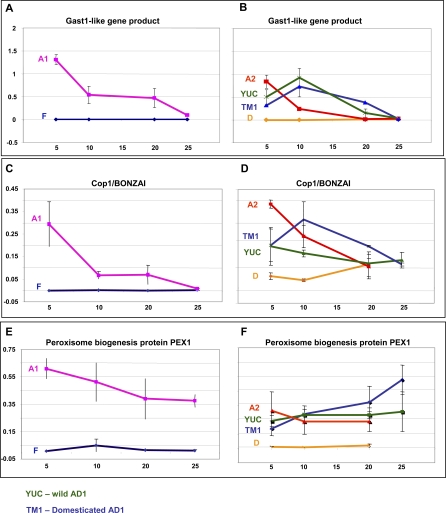
Quantitative Real-Time PCR Analyses of Three Candidate Genes Controlling H2O2 Levels
Gossypium species investigated were G. herbaceum (A1), G. longicalyx (F) (left panel); G. hirsutum var TM1 (TM1), G. hirsutum var yucatanense (YUC), G. arboreum (A2), and G. raimondii (D5) (right panel). Each point on the graph represents the mean of three biological replications.